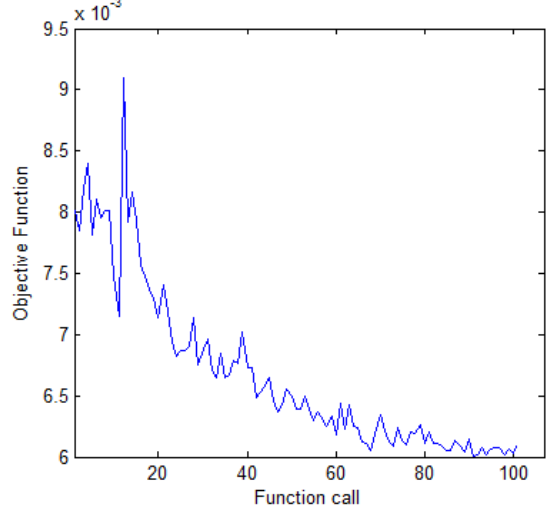
Figure 12. The objective function change during the second optimization.